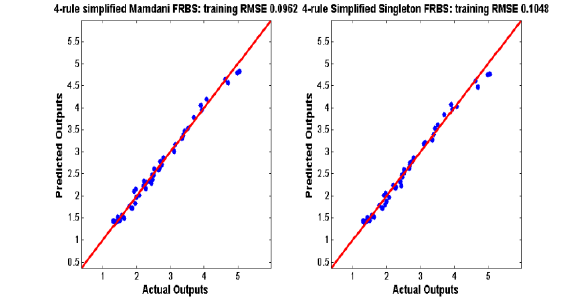
Fig. 10. Predictive performances of the simplified Mamdani and Singleton FRBSs.